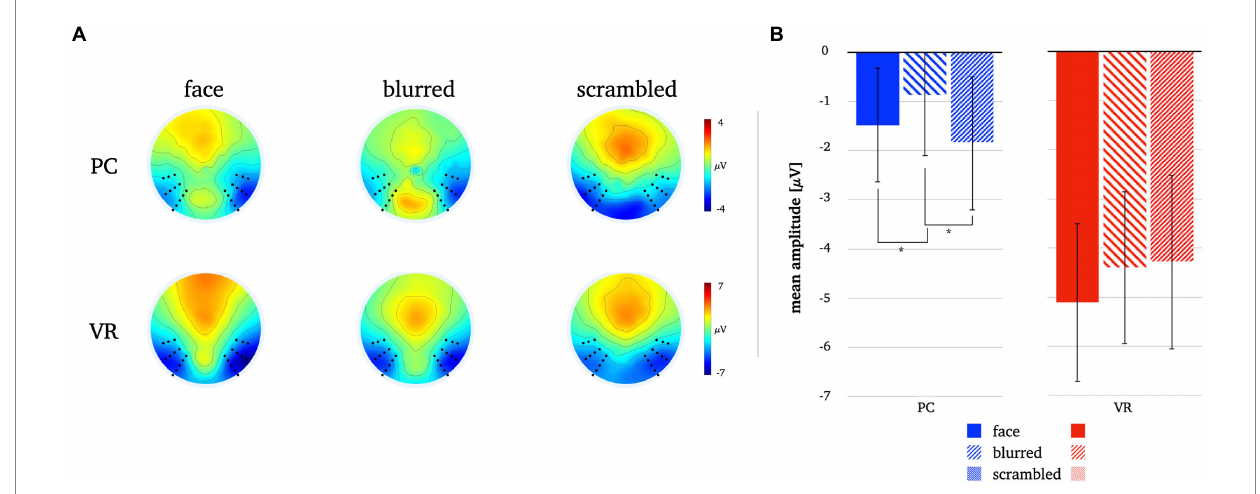
FIGURE 8 Panel A illustrates the N170 topographies for all stimulus types in both modalities. Panel B depicts the mean N170 amplitudes for all stimulus types in both modalities. The error bars depict the confidence intervals for the mean values. Significant differences within each modality are marked (* p < 0.05).